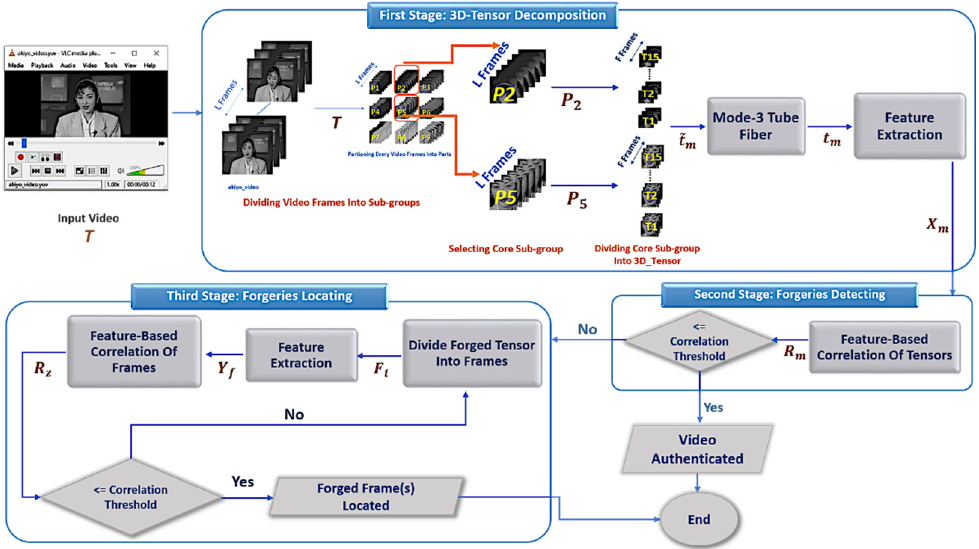
Figure 2. The proposed methodology.